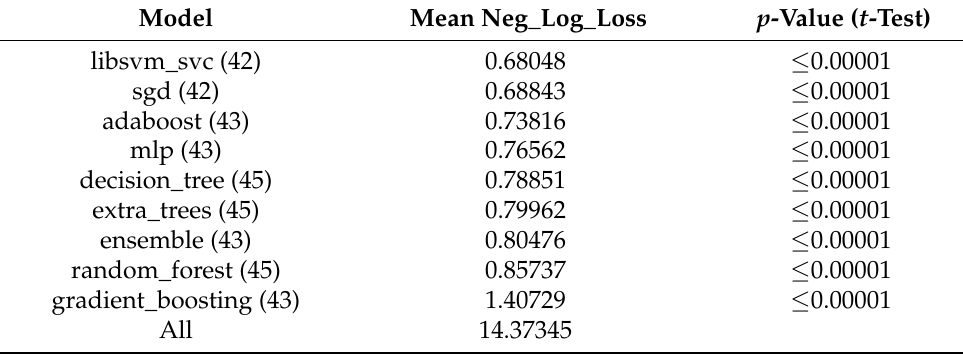
Table A12. Models with significantly better mean log loss.